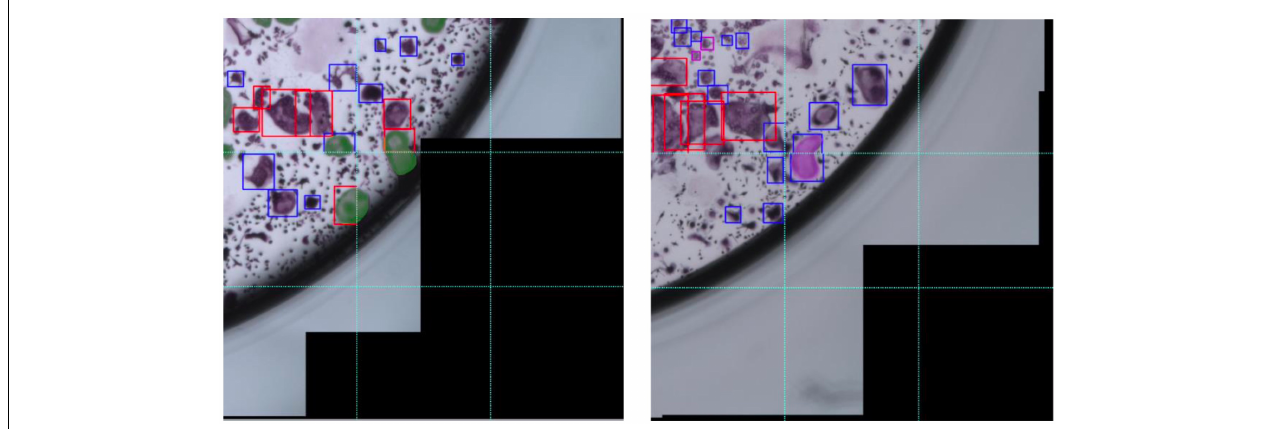
FIGURE 11 | Error in annotation due to overlapping of cells over multiple patches. These two cropped images of cultures are divided into 9 smaller patches. Left: Cells that are split across different patches are marked in opaque green. Right: a single cell split across different patches is marked in opaque violet and is covered by two bounding boxes, one in the upper patch and one in the lower